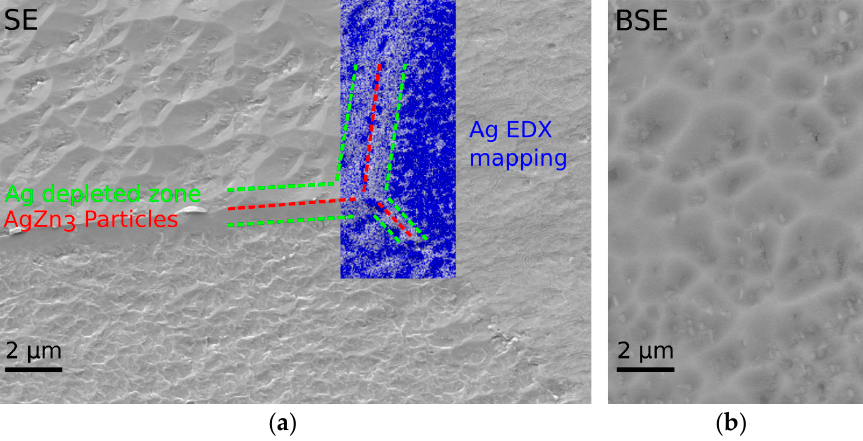
Figure 4. Scanning electron microscope (SEM) investigation of the microstructure after thermomechanical treatment. ( a ) For the sake of resolution, SE imaging of the BIB polished surface and the corresponding EDX analysis were performed at 6 kV. The overlay shows that ε -AgZn 3 particles have formed along the grain boundaries while the proximity is Ag depleted; ( b ) the 20 kV BSE imaging revealed the presence of ε -AgZn 3 precipitates within the Zn grains.